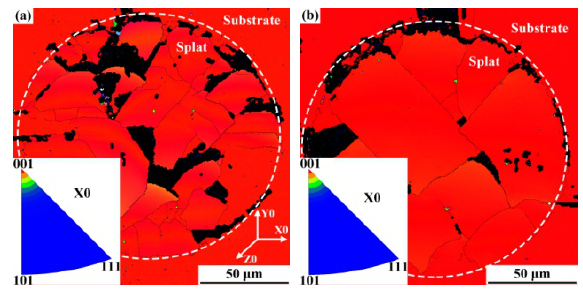
Fig. 5 Orientation maps of 7YSZ splats at the deposition temperature of (a) 100 and (b) 600 ℃ . The inverse pole figures (IPFs, the inserts) and the identical colors clearly indicated epitaxial growth readily occurred along <001> directions. The dash white circle showed the outline of splat. The white arrows with X0, Y0, and Z0 in (a) presented the crystal orientation coordinate system corresponding to [100], [010], and [001] orientation, respectively.